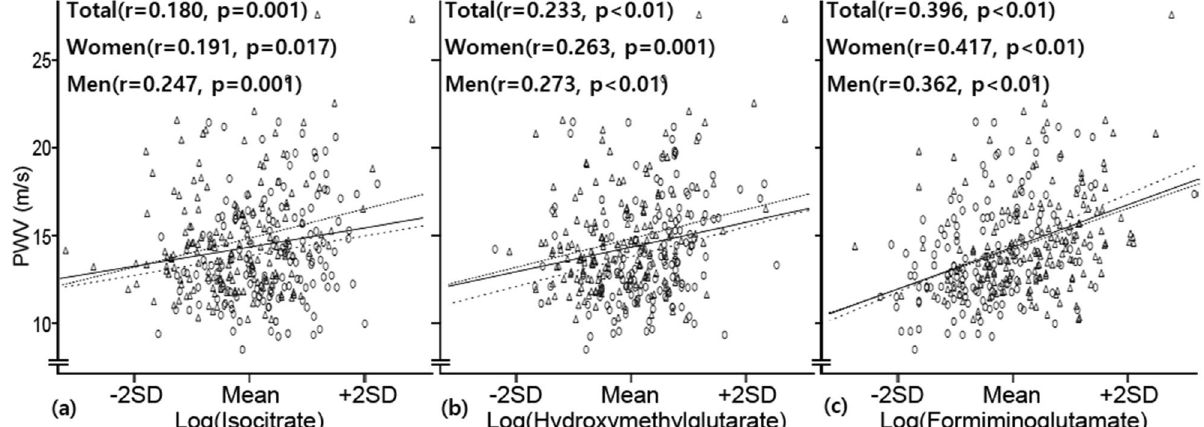
Figure 1. The Scatter plots of the levels of key metabolites with baPWV. Each concentration of the metabolites (isocitrate ( a ), hydroxymethylglutarate ( b ) and formiminoglutamate ( c )) is logarithmically transformed and standardized. Men are shown as triangles, and women are displayed as circles. Solid lines are fit for all subjects; dense dotted lines are fit for men, and sparse dotted lines are fit for women. r indicates Pearson correlation coefficients. BaPWV brachial-ankle pulse wave velocity, PWV , pulse wave